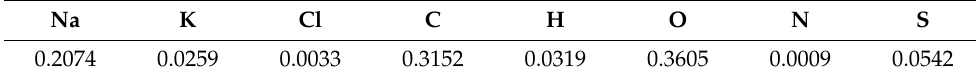
Table 1. Black liquor dry solids composition [kg/kg ds ].